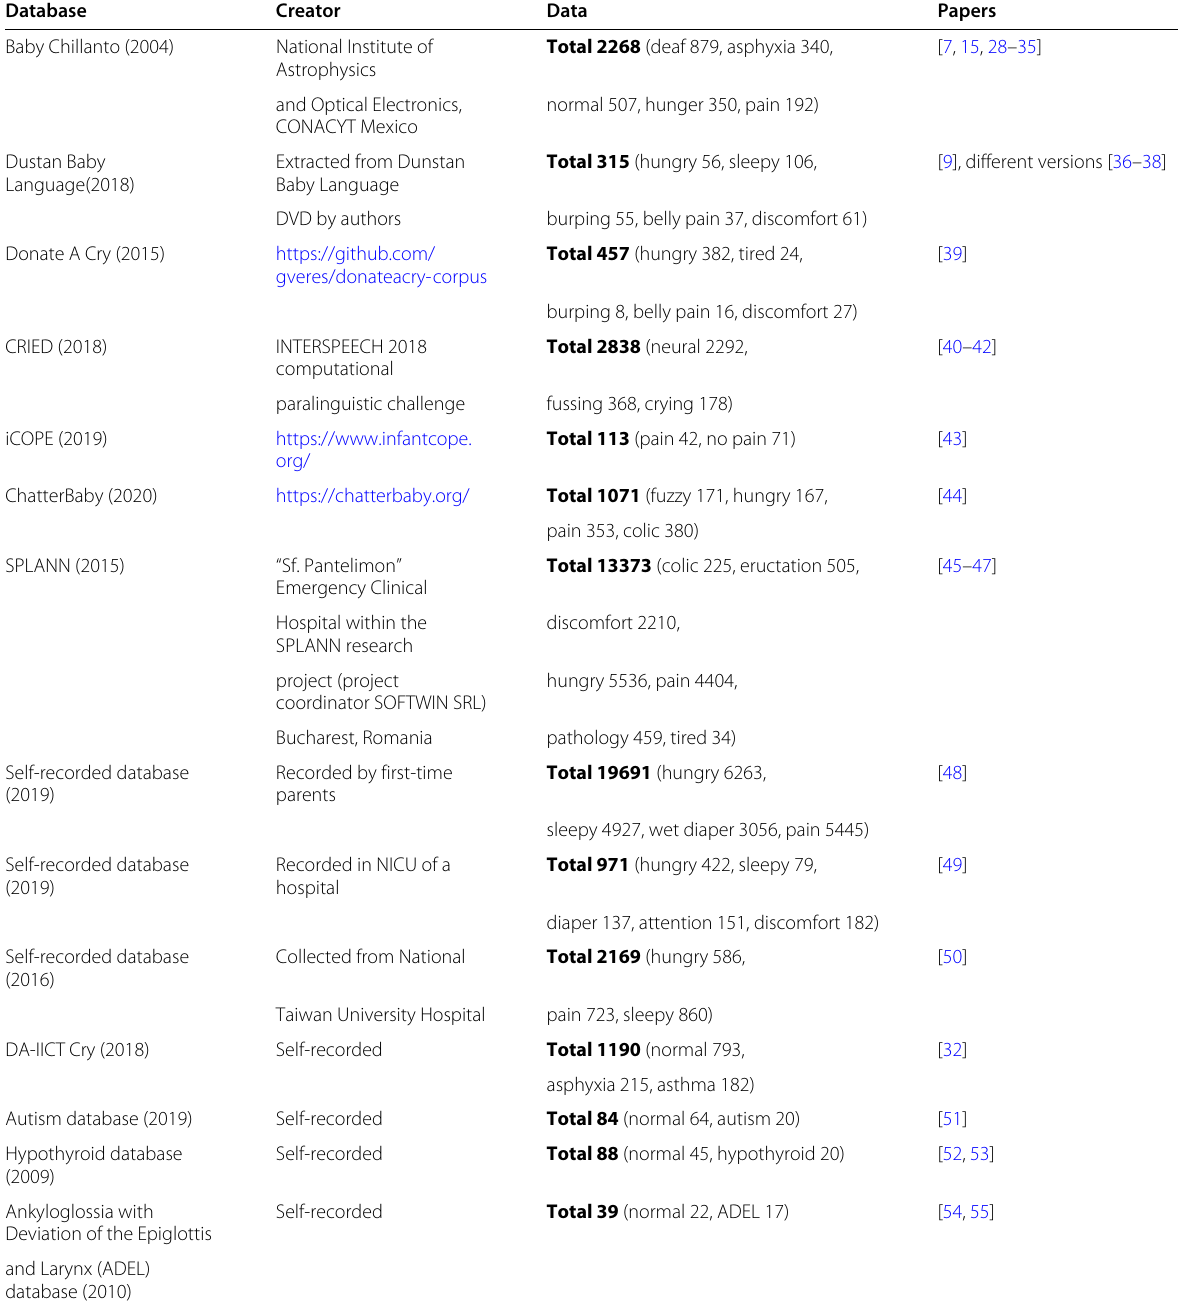
Table 1 Main databases used in literatures